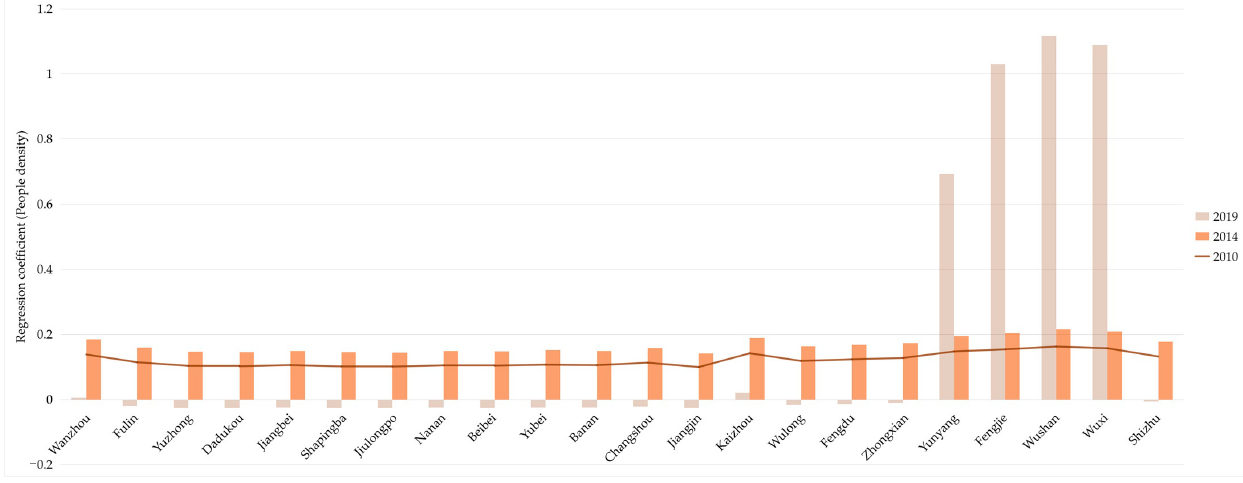
Figure 13. Changes of regression coefficient of P-UDI in the Three Gorges Reservoir Area (Chongqing section). Sources: Calculation results of the GWR model from the population dimension.